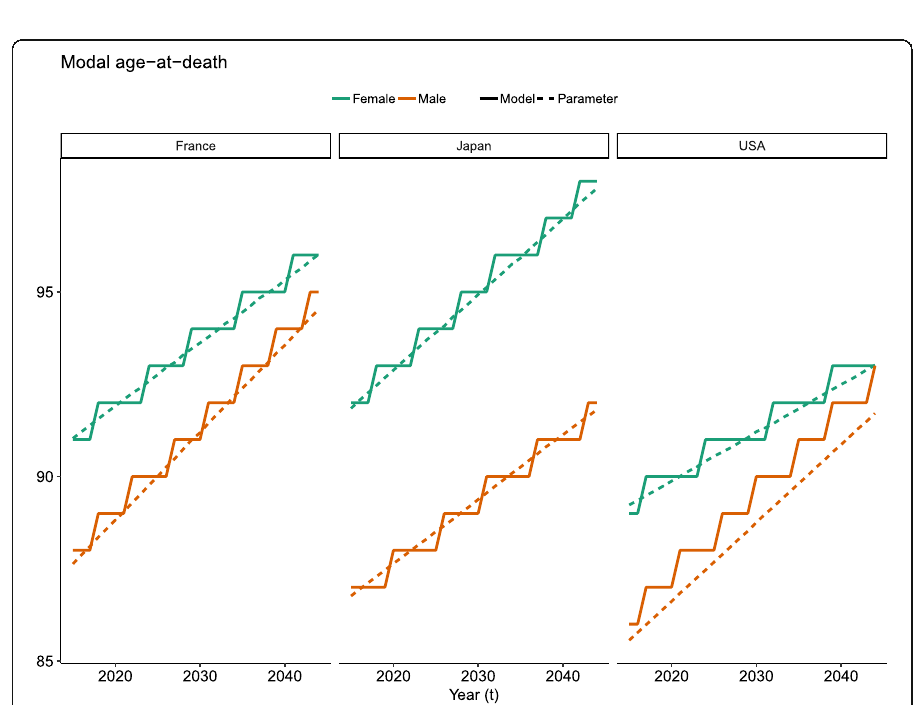
Fig. 15 Comparison of the parameter M t with the modal age based on the estimated age-at-death distribution using CoDe 2.1 model for the years 2015 –